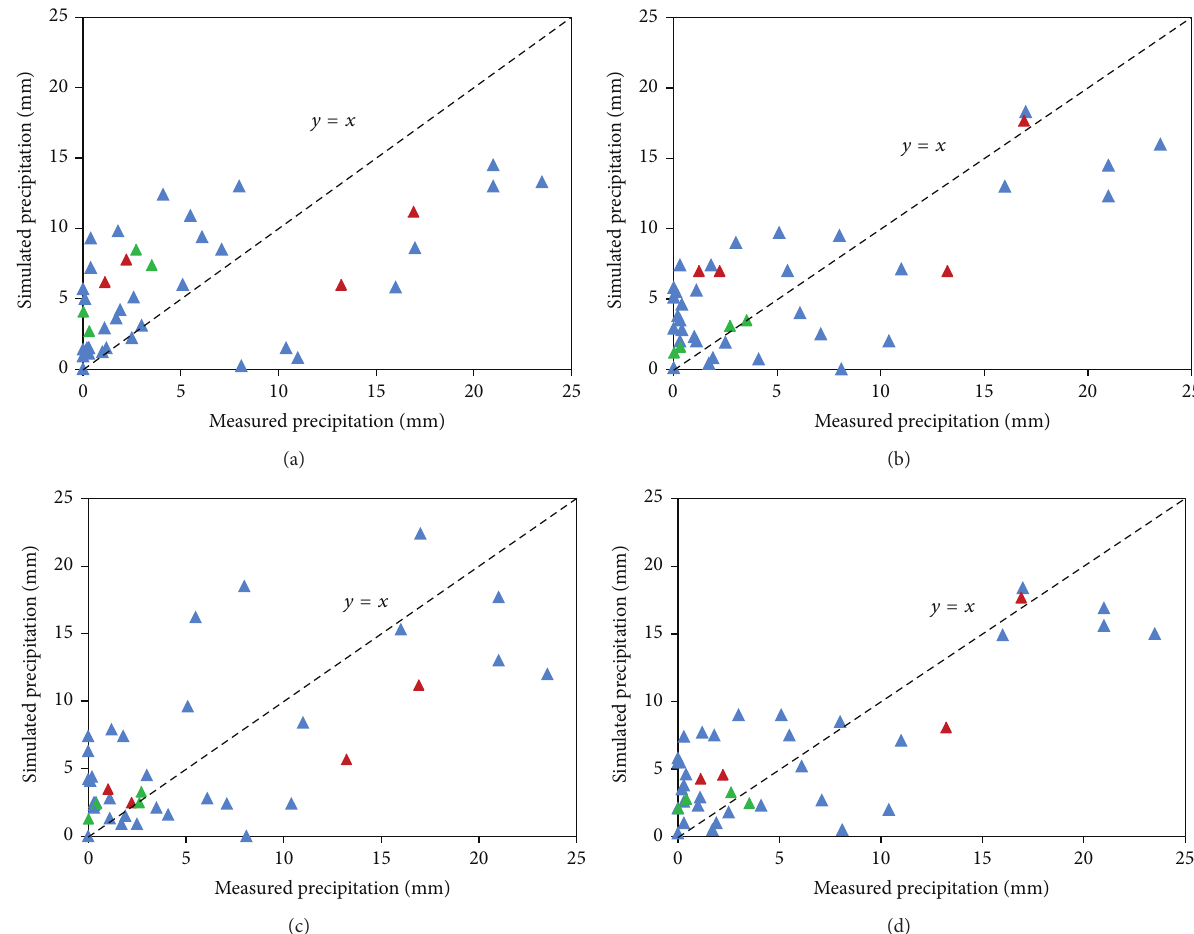
Figure 8: Differences between rainfall values measured at the sites and those from the numerical experiments for Event B: (a) CTRL; (b) DA-SAT; (c) DA-OBS; (d)